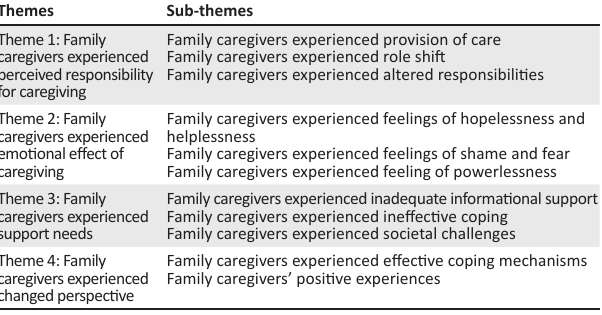
TABLE 2: Family caregivers’ experiences for persons living with mental illness.